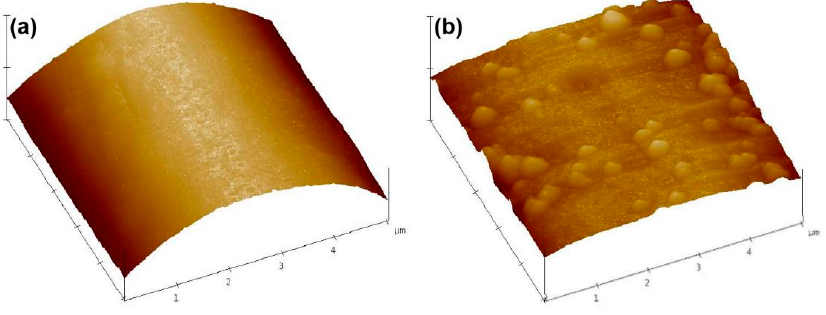
Figure 5. Atomic force microscopy (AFM) images of ( a ) original PET fiber; ( b ) Cu/Ag/PDA/PET fiber reaction time of 2 h.